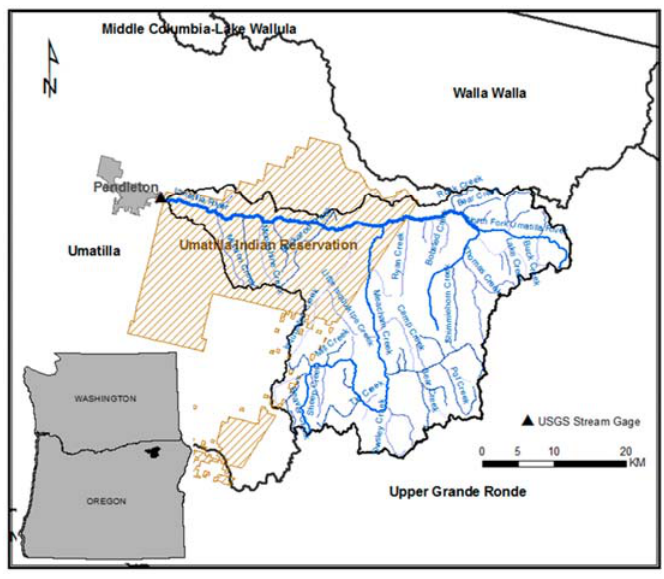
Figure 1. The study site is 2365 km 2 in the upper Umatilla River Basin in northeastern Oregon.